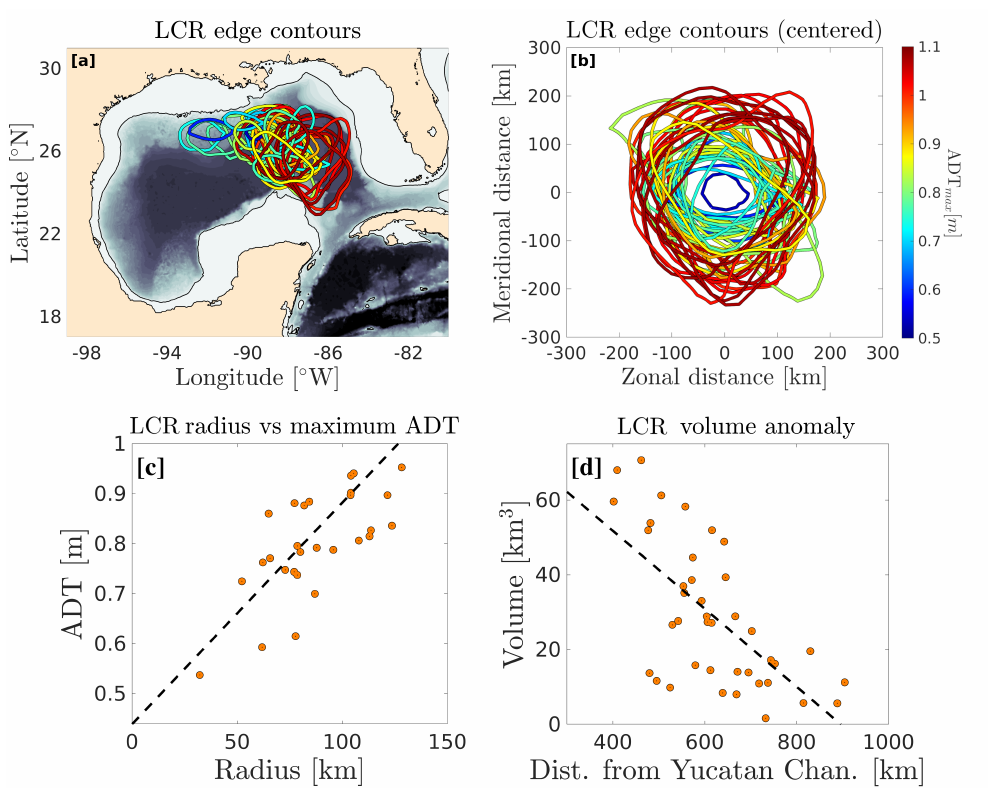
Figure 5. ( a ): Map of the edge contours of the 40 detected Loop Current rings (LCRs) one day after detachment. The maximum absolute dynamic topography (ADT) value within each eddy is color coded. ( b ): Same as ( a ) in an eddy-centric frame: the x and y axis are the distance (in km) from the eddy’s rotation axis. The color code is the same as in ( a ). ( c ): Maximum ADT value (at the eddy’s center) against eddy’s radius. ( d ): Volume anomaly (surface-integral of the ADT anomaly) against distance from the Yucatan